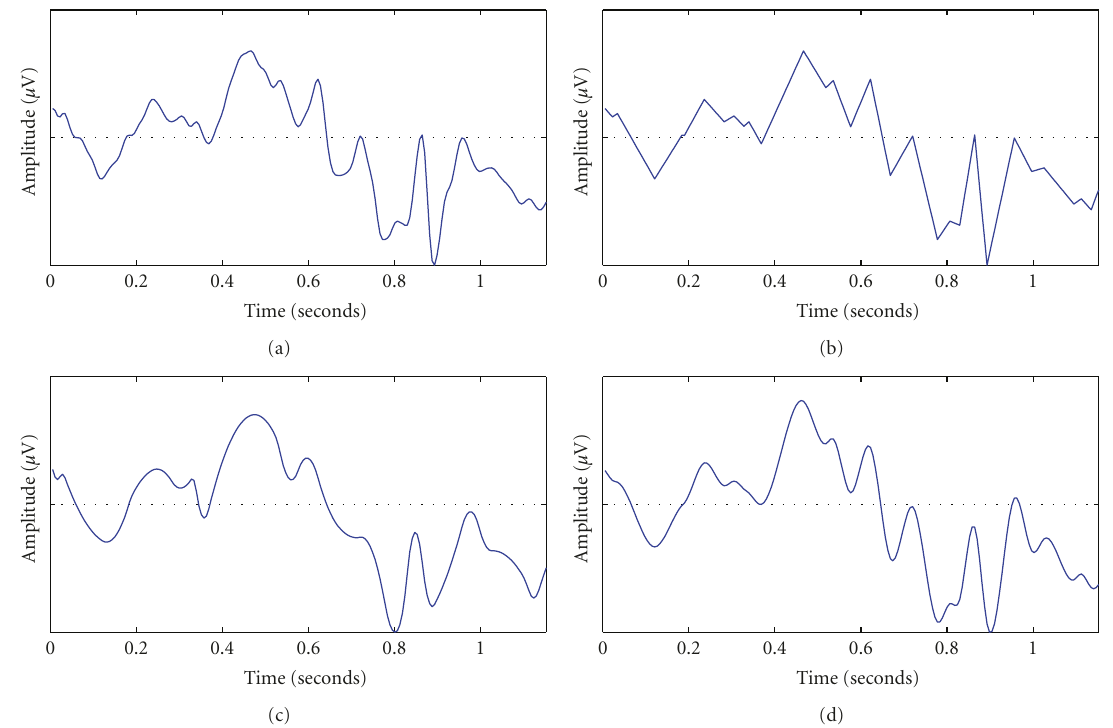
Figure 1: Comparison of di ff erent spline models of EEG. (a) Original EEG signal; (b) Linear spline model, CC = 99 . 22%, RMSE = 0 . 0020, PRD = 13 . 07%, MAXERR = 0 . 0012; (c) Quadratic spline model, CC = 96 . 00%, RMSE = 0 . 0046, PRD = 29 . 65%, MAXERR = 0 . 023; (d) Cubic spline model CC = 99 . 13%, RMSE = 0 . 0021, PRD = 13 . 65%, MAXERR = 0 .